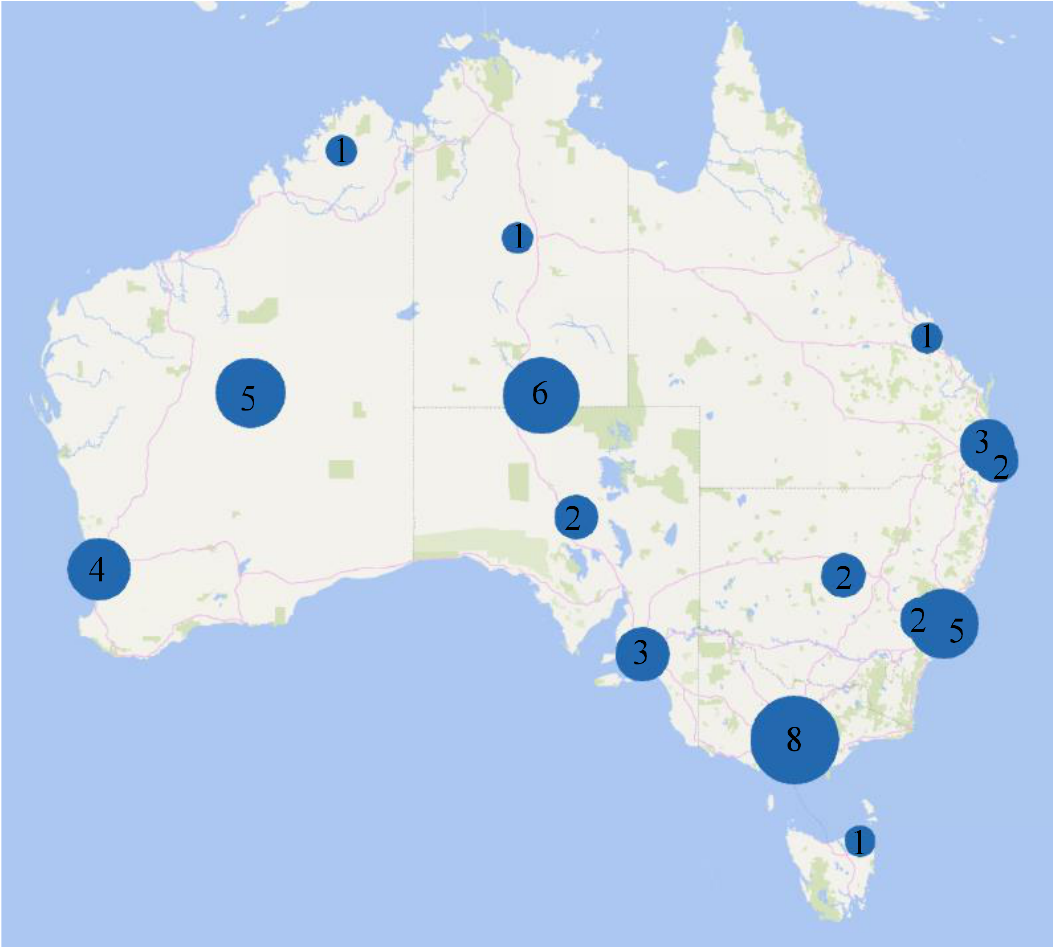
Figure 2. Geographic distribution of 57 studies included in a systematic review of the measurement of food insecurity in Australia.